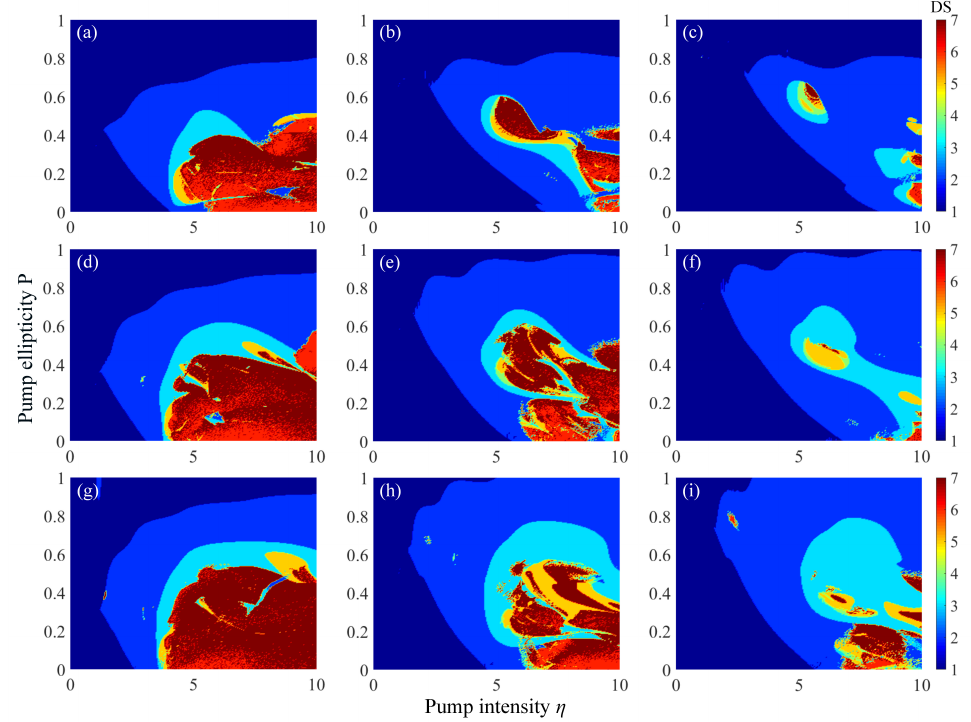
Figure 7. Mapping of the different dynamic states of spin-VCSEL with optical feedback in the parameter space of ( η , P ) with τ = 0.5 ns and k = 0.4 ns − 1 , where ( a ) α = 2, γ s = 20 ns − 1 ; ( b ) α = 2, γ s = 40 ns − 1 ; ( c ) α = 2, γ s = 50 ns − 1 ; ( d ) α = 3, γ s = 20 ns − 1 ; ( e ) α = 3, γ s = 40 ns − 1 ; ( f ) α = 3, γ s = 50 ns − 1 ; ( g ) α = 4, γ s = 20 ns − 1 ; ( h ) α = 4, γ s = 40 ns − 1 ; ( i ) α = 4, γ s = 50 ns − 1 . The other parameters are the same as those given in the preceding discussion. 1: steady state; 2: P1; 3: P2; 4, 5: multi-period; 6, 7: chaos